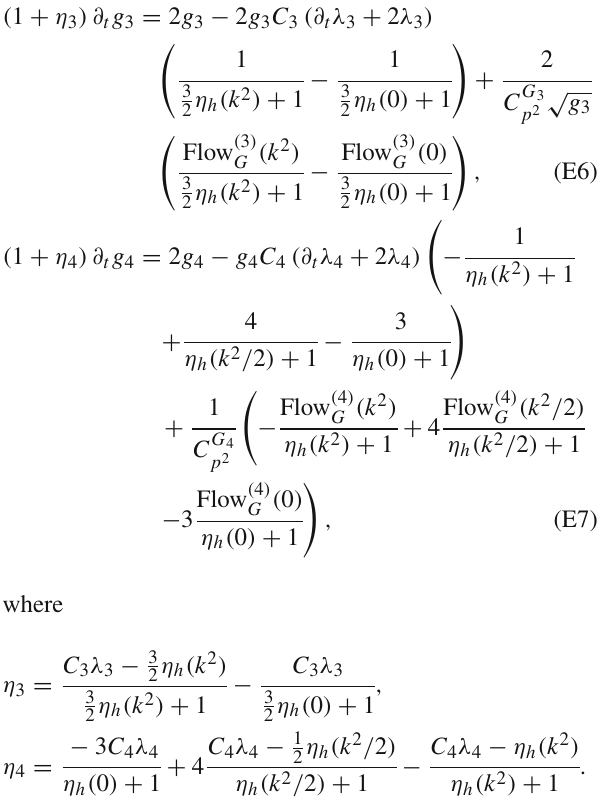
scheme λ n > 4 = λ 3 and g n > 4 = g 4 .Thecriticalexponents ¯ θ i and ˜ θ i stem from two different approximation of the stability matrix as discussed in Appendix 1. The fixed point properties from different approximations are qualitatively very similar. In particular, all fixed points exhibit three relevant directions when the first approximation of the stability matrix is used. Using the second approximation of the stability matrix also results in three relevant directions in three out of four cases